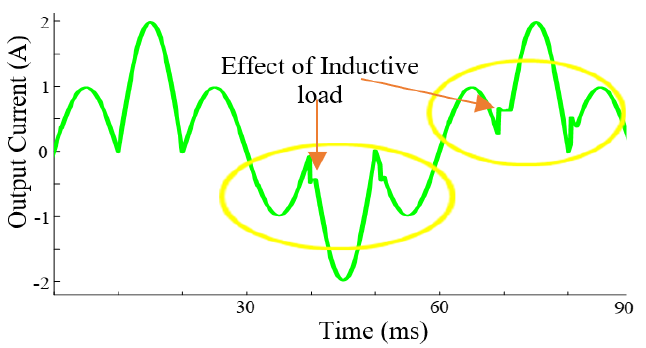
Figure 9. Output current of one − third frequency conversion of input frequency for motor load.